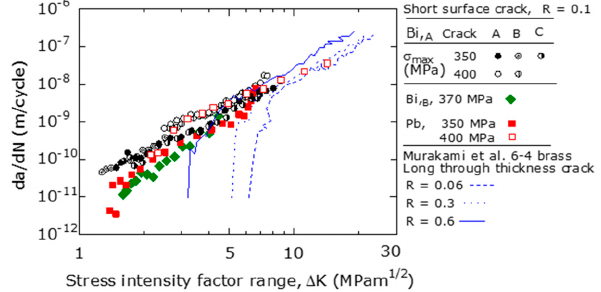
Figure 10. d a /d N − Δ K relationships for three types of brasses ( R = 0.1).